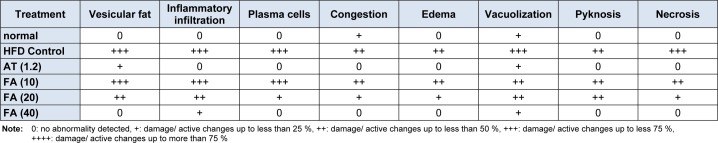
Effect of ferulic acid on HFD-induced alteration in rat liver